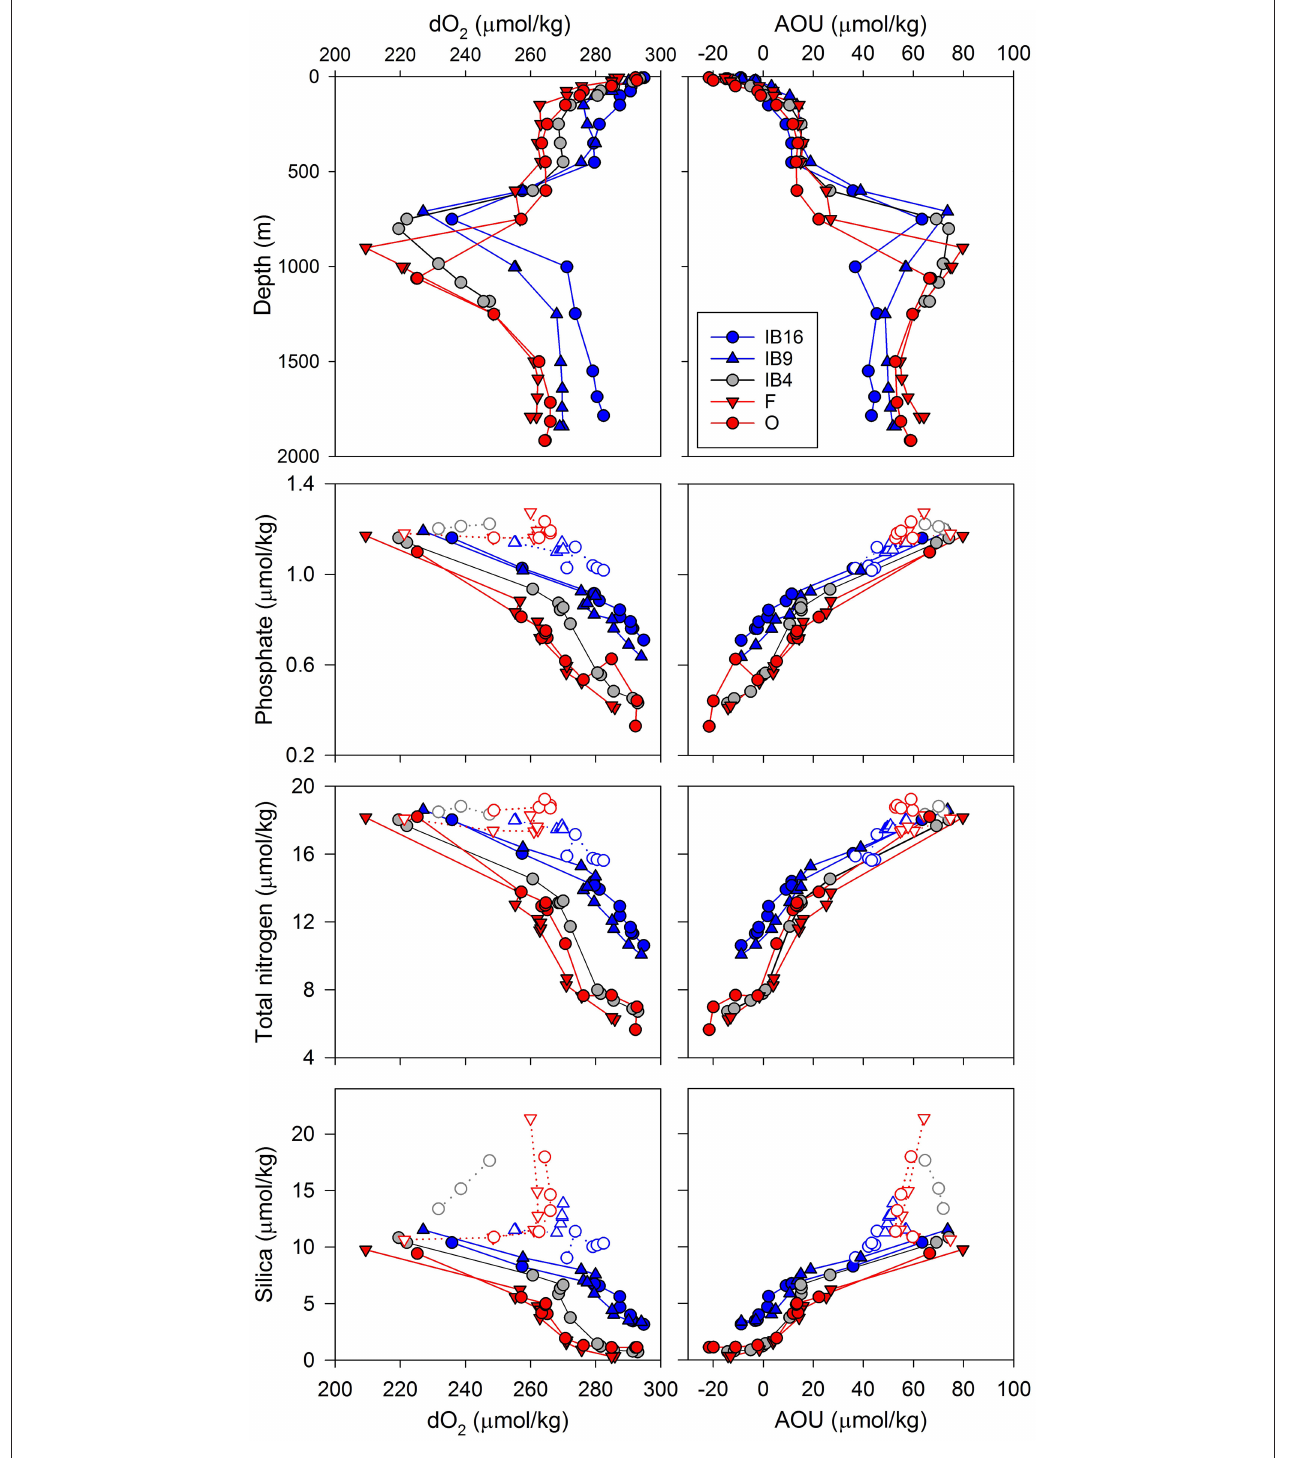
FIGURE 12 | Depth variation of dissolved oxygen concentrations ( µ mol/kg) at the 5 open ocean stations in this study (left column) . The apparent oxygen utilisation (AOU; µ mol/kg) is also shown for comparison (right column) . Lower panels show nutrient concentrations (phosphate, total nitrogen, silica) vs. dissolved oxygen and AOU ( µ mol/kg) at the same stations. The open symbols represent waters below the permanent pycnocline.